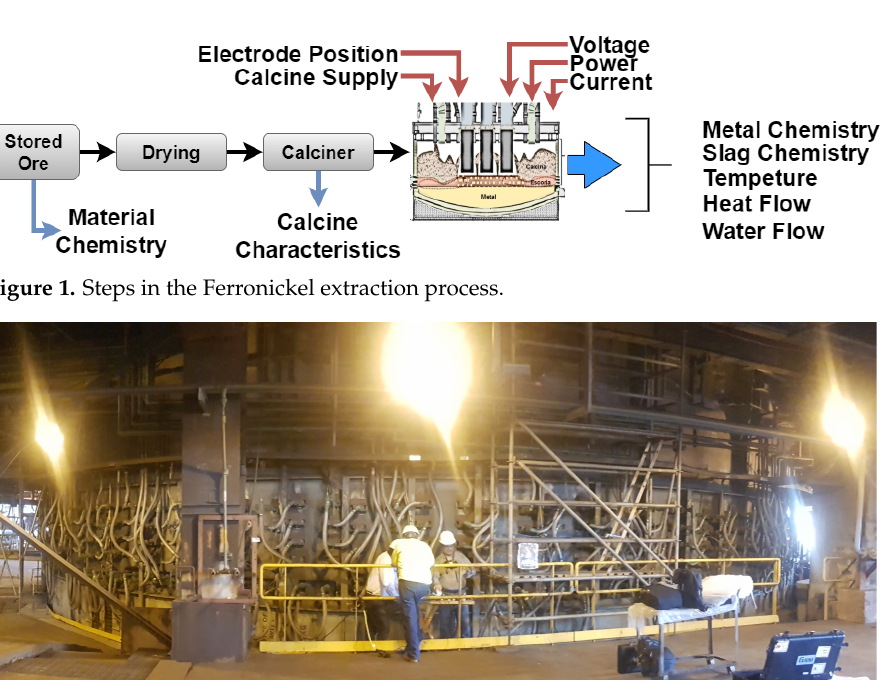
Figure 2. Panoramic of the